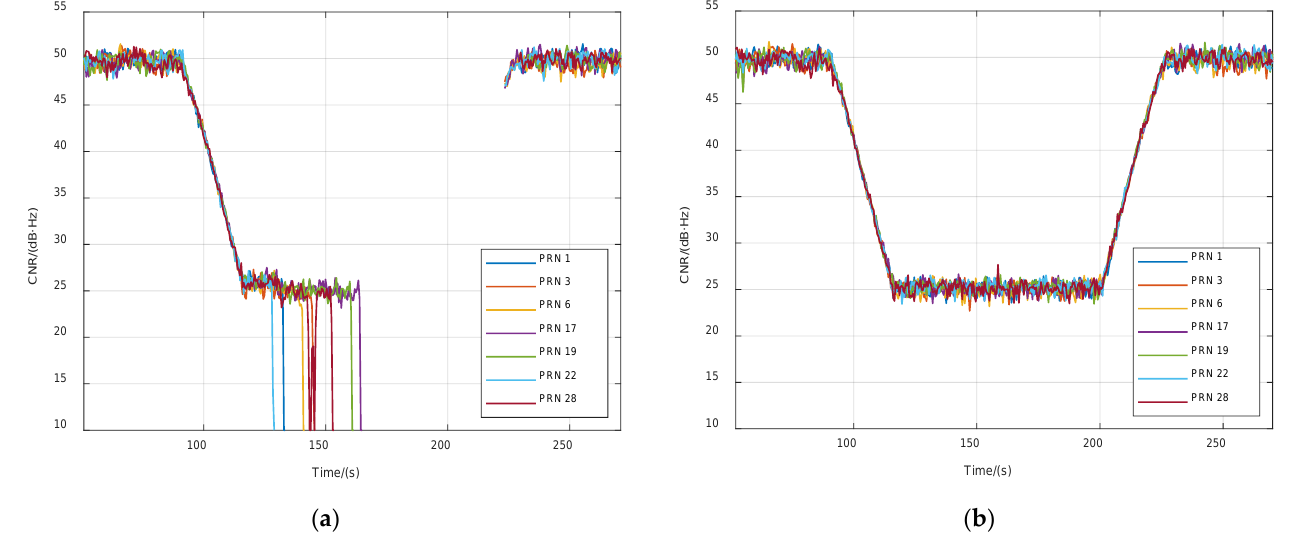
Figure 12. CNR of tracking satellites in case of signal attenuation. ( a ) STL; ( b ) VTL.